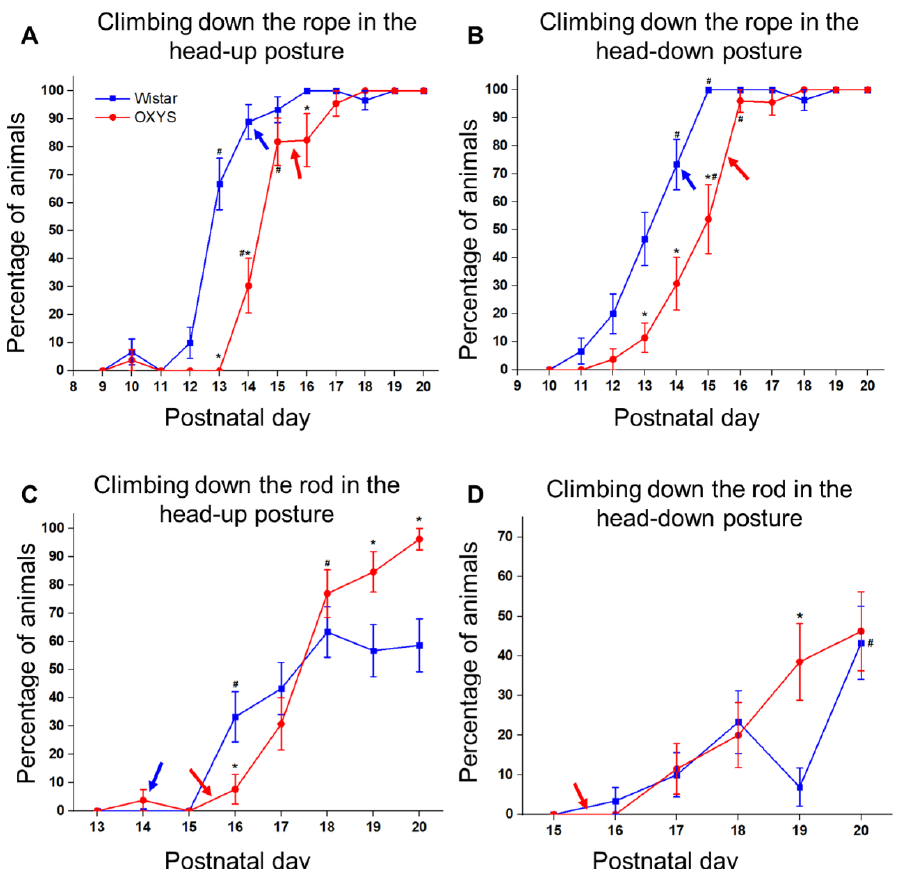
Figure 6. The abilities of OXYS and Wistar pups to climb down the rope and rod. ( A ) Climbing down the rope in the head-up posture; ( B ) climbing down the rope in the head-down posture; ( C ) climbing down the rod in the head-up posture; ( D ) climbing down the rod in the head-down posture. * p < 0.05 as compared to control (Wistar) rats; # p < 0.05 as compared to previous day; blue arrow: eye opening in Wistar pups; red arrow: eye opening in OXYS pups. The data are presented as the mean ± SEM.